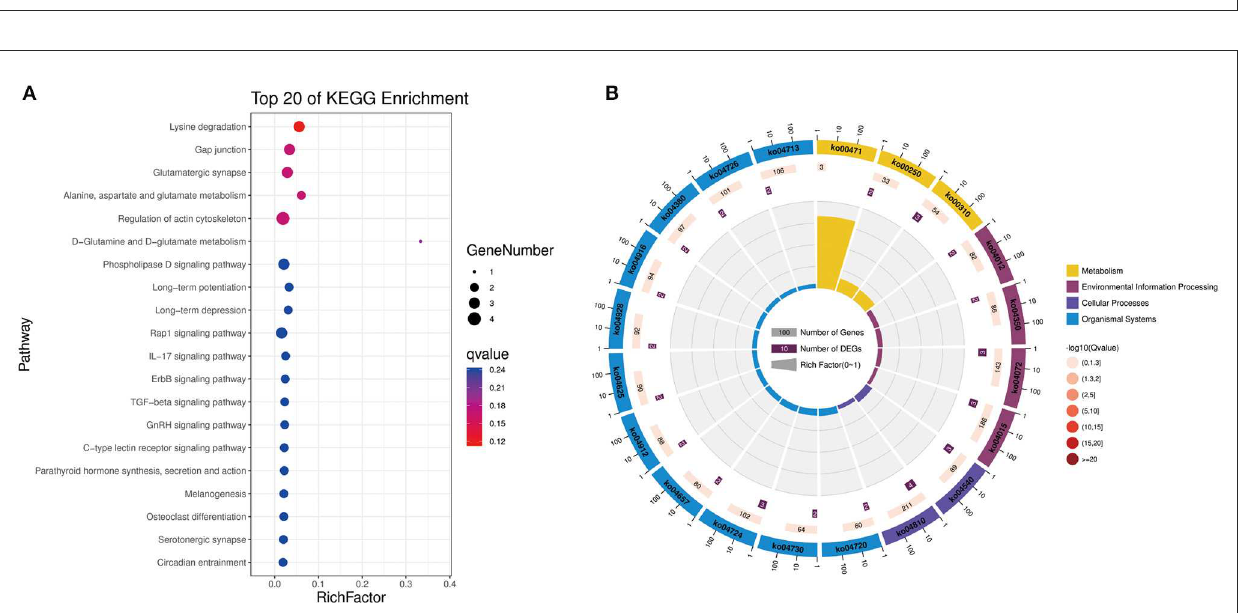
FIGURE4 KEGG pathway annotation of significantly DE circRNAs from host source genes. (A) Gradient map for KEGG pathway annotation of significantly DE circRNAs from NDV-infected CEFs. (B) Circular map for KEGG pathway annotation of significantly DE circRNAs from NDV-infected CEFs.